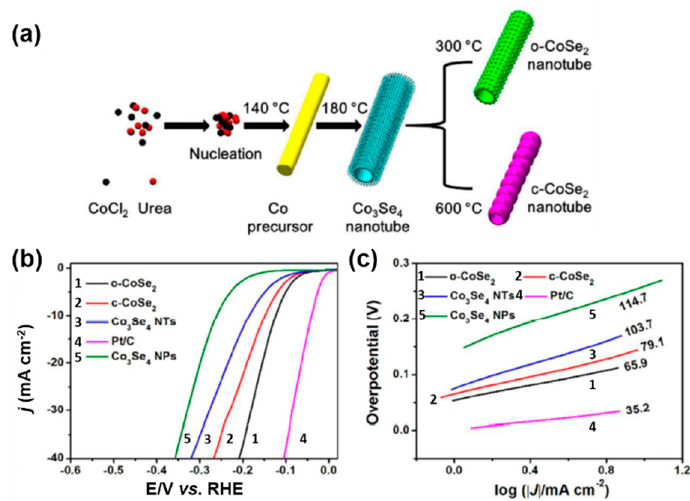
Figure 20. ( a ) Synthesis route of CoSe 2 nanotubes; ( b ) iR -corrected HER polarization curves (cathodic sweep) of o–CoSe 2 , c–CoSe 2 , Co 3 Se 4 NTs, Pt/C and Co 3 Se 4 nanoparticles (NPs) catalysts at a scan rate of 5 mV s − 1 in 1 M KOH solution; and ( c ) Tafel slopes analysis of all the catalysts. The mass loading of the catalyst was ~0.283 mg cm − 2 . Reproduced from [168], Copyright © Royal Society of Chemistry,